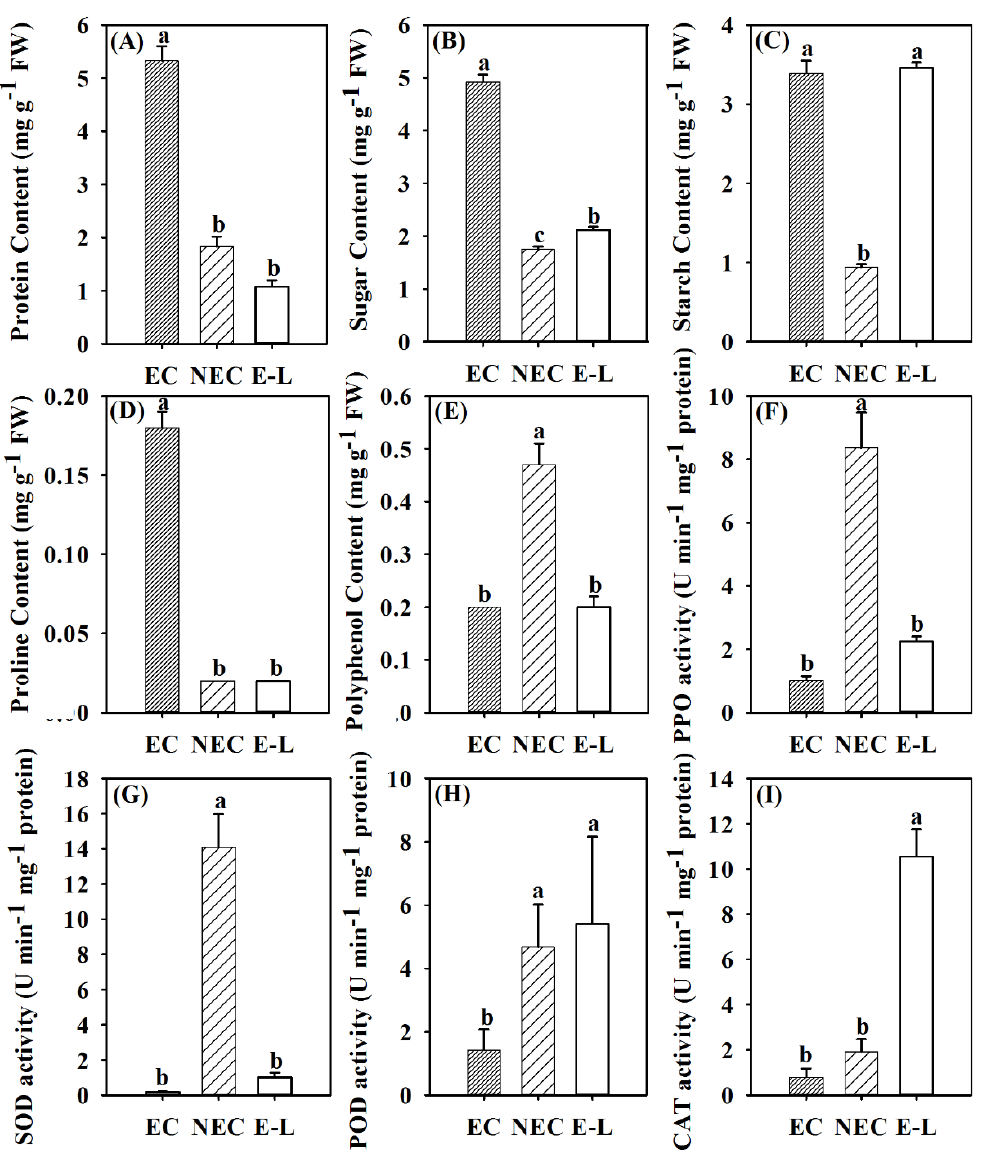
Figure 2. Physiological differences between different callus tissues of Korean pine on the 7th day of culture on proliferation medium. ( A ) Protein content, ( B ) Sugar content, ( C ) Starch content, ( D ) Proline content, ( E ) Polyphenol content, ( F ) PPO activity, ( G ) SOD activity, ( H ) POD activity, ( I ) CAT activity. EC: Embryogenic callus; NEC: Non-embryogenic callus; E-L: callus which has lost somatic embryogenesis potential. Different letters above bars indicate significant differences between samples. (Duncan’s test; P = 0.05).